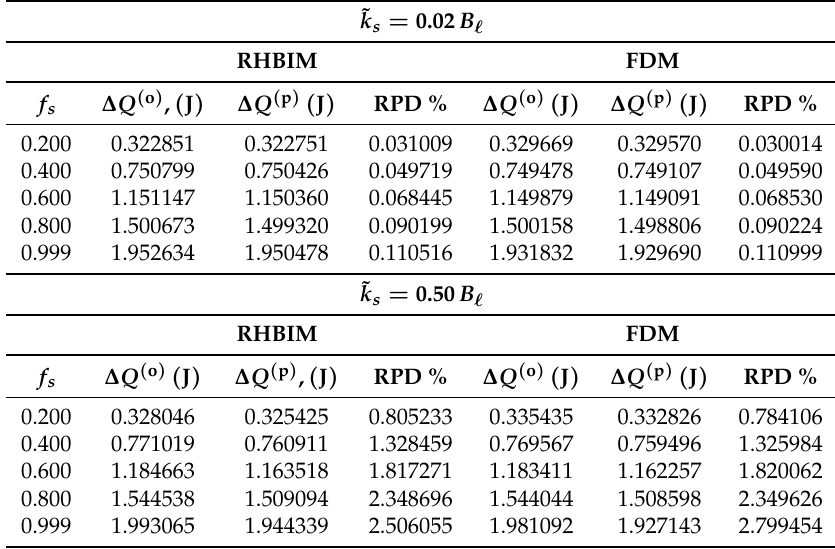
Table 2. Calculated values of ∆ Q at different melted solid fractions f s